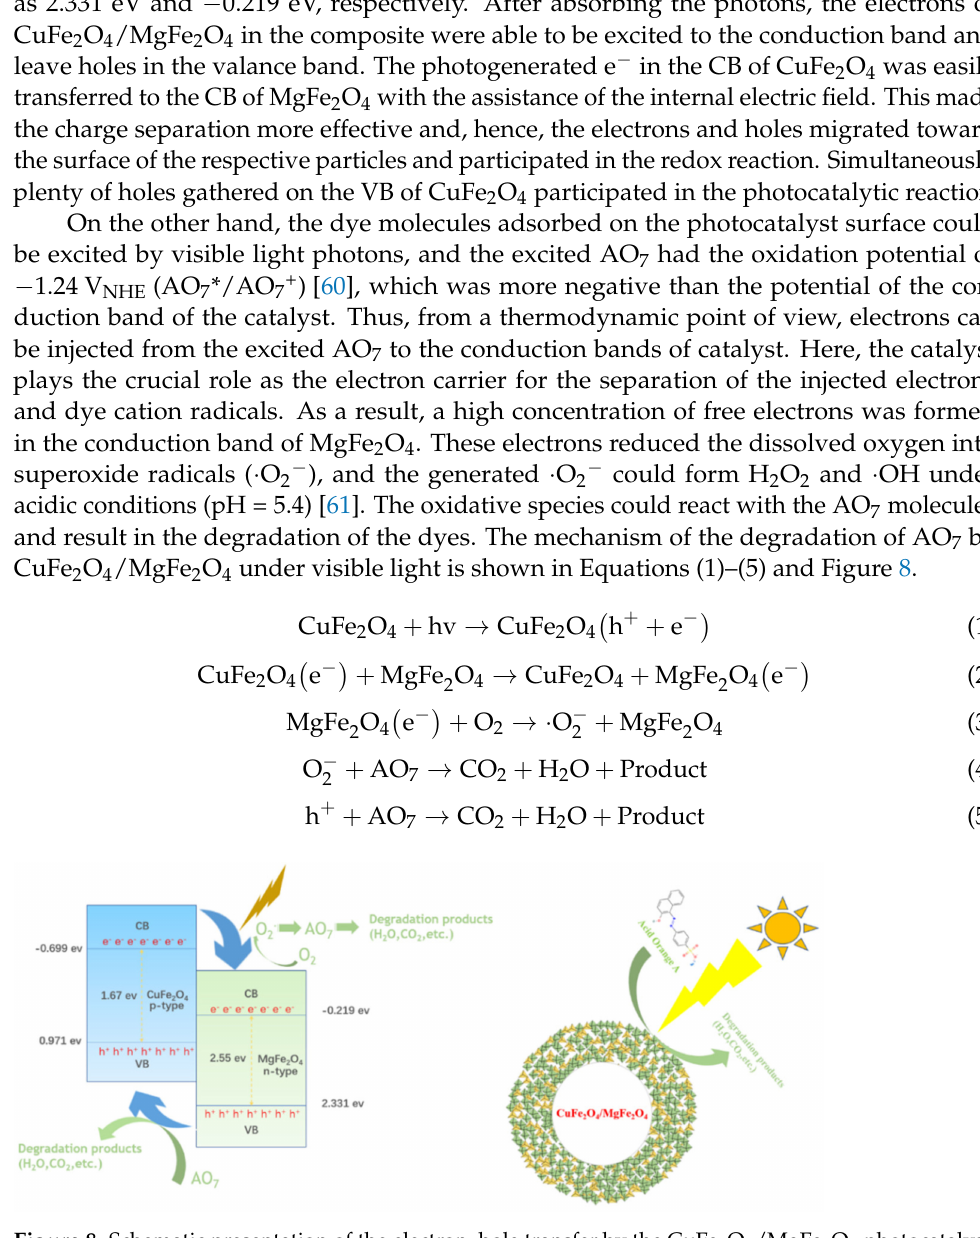
Figure 8. Schematic presentation of the electron–hole transfer by the CuFe 2 O 4 /MgFe 2 O 4